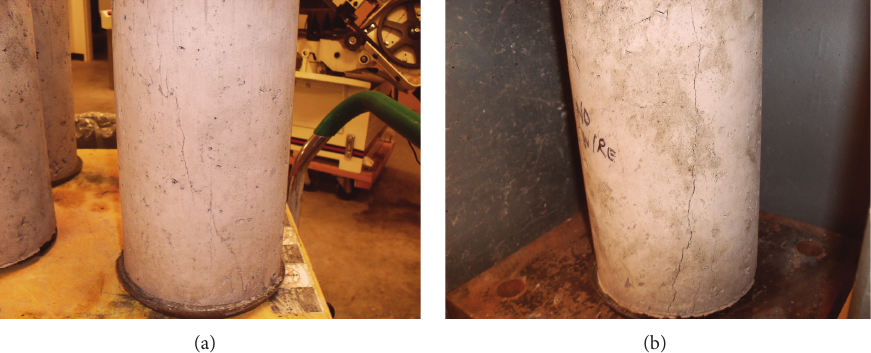
Figure 7: 7.5% TDA-1 󸀠󸀠 concrete failure patterns. The fracture line was generally at an angle to the loading